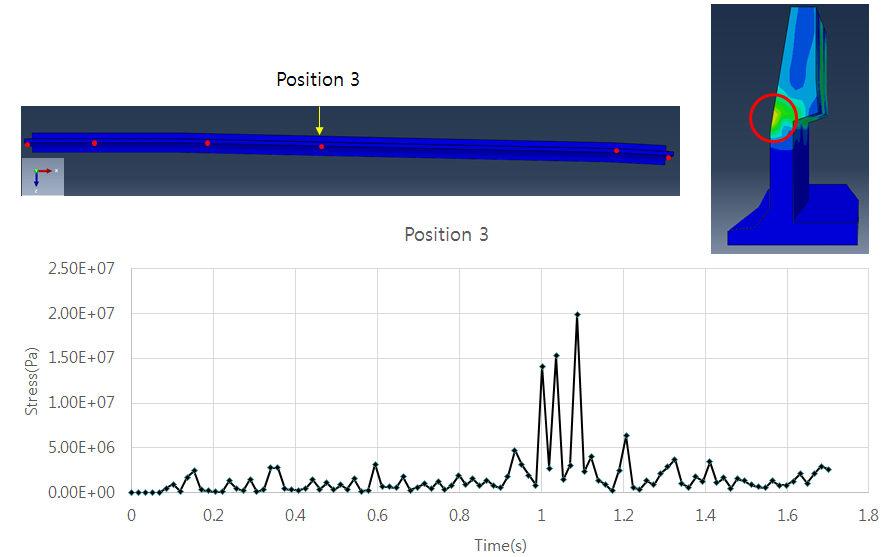
Figure 6. Histories of maximum von Mises stress at 5 km / h bogie’s speed.